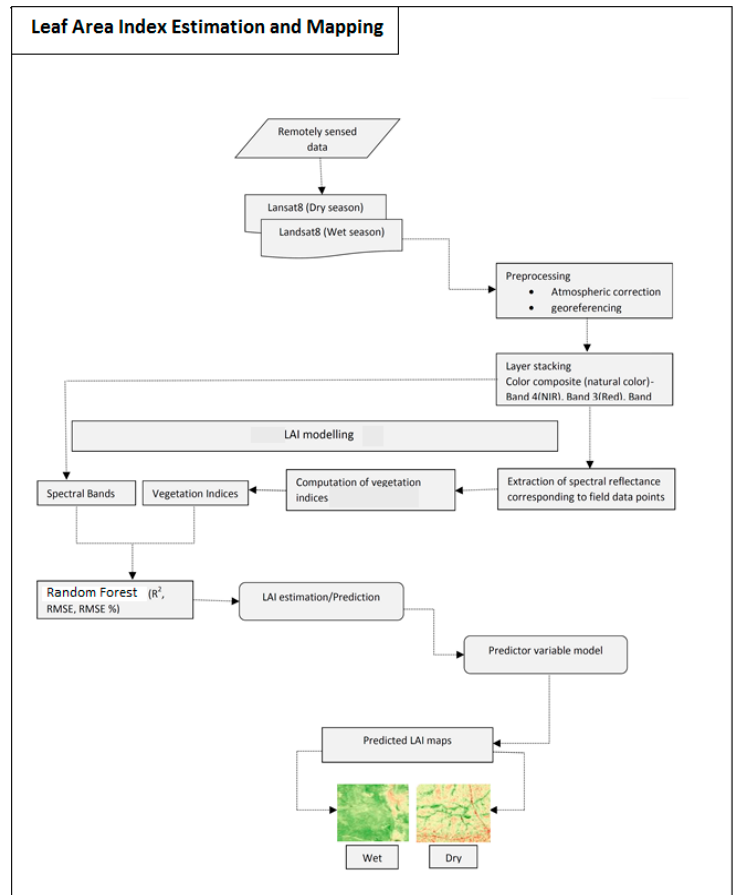
Figure 3. Seasonal LAI computation using is-situ and remotely sensed data.